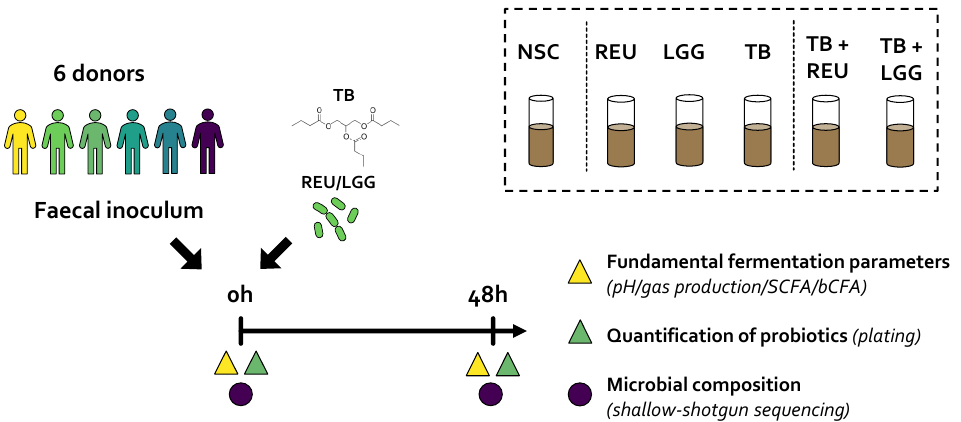
Figure 7. Experimental design using SIFR ® technology platform to test the impact of tributyrin oil (TB), Lactobacillaceae species (REU and LGG) and combinations thereof on the human gut microbiota. Fecal samples from 6 healthy donors were cultivated ex vivo to assess the impact on the microbial metabolite production and composition. REU = Limosilactobacillus reuteri ATCC 53608; LGG = Lacticaseibacillus rhamnosus GG ATCC 53103; SCFA = short chain fatty acids; bCFA = branched fatty acids.